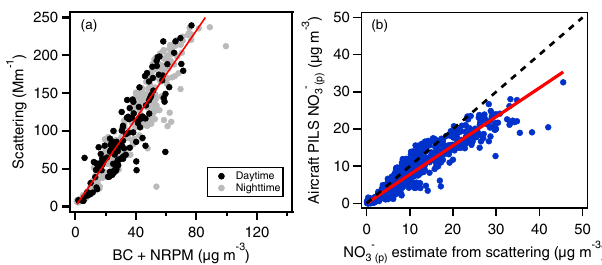
Figure A1. (a) Total particle scattering at 550nm (Mm − 1 ) ver- sus PM 1 . 0 mass (submicron black carbon (BC) + non-refractory PM 1 . 0 (NR-PM 1 )) concentration (µgm − 3 ) observed at ground level in Fresno. The solid red line is the orthogonal distance regression fit including data only during the daytime (black circles) between con- 08:00LT and 16:00LT; slope = 2.83mm 2 µg − 1 . (b) NO − 3 ( p ) centration measured by PILS on P3-B aircraft versus that estimated = γ · σ from scattering using the relation NO − sca , dry / 2 . 83. The 3 ( p ) solid red line is the linear fit to the data, with slope = 0.78. The dashed black line is the 1 : 1